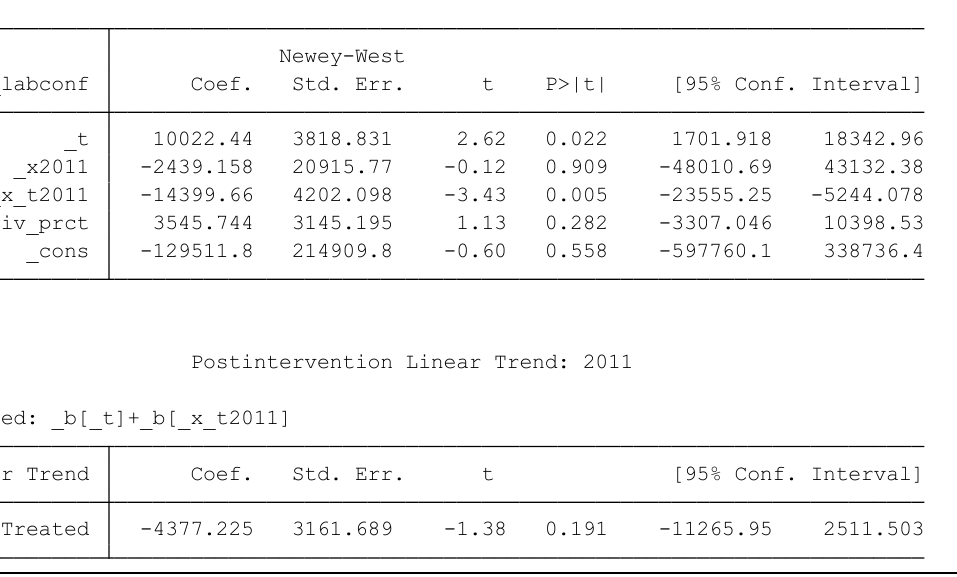
FIGURE 4: Actual and predicted new laboratory-confirmed cases in South Africa controlling for TB/HIV